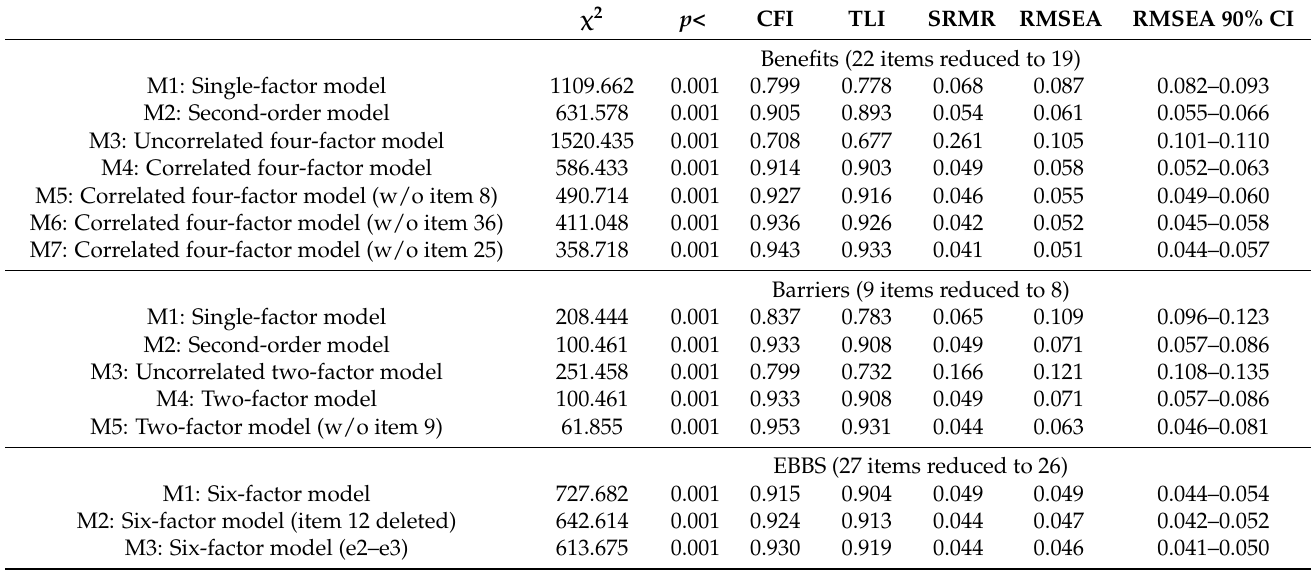
Table 4. CFA of the benefit scale, barrier scale, and EBBS